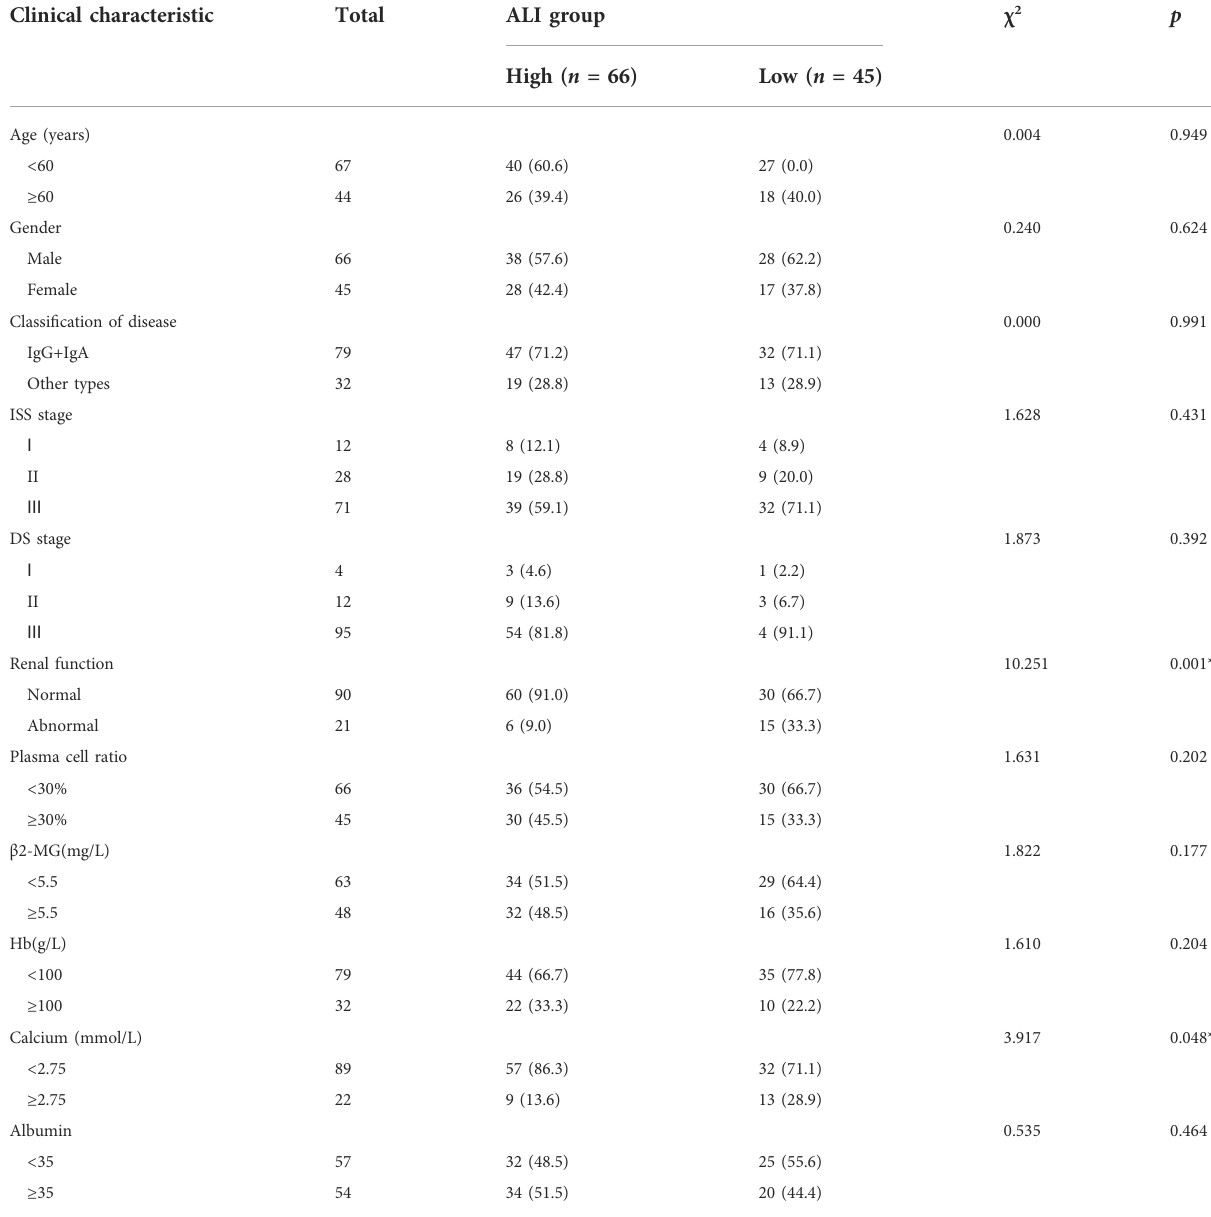
TABLE 2 Baseline clinical characteristics according to the